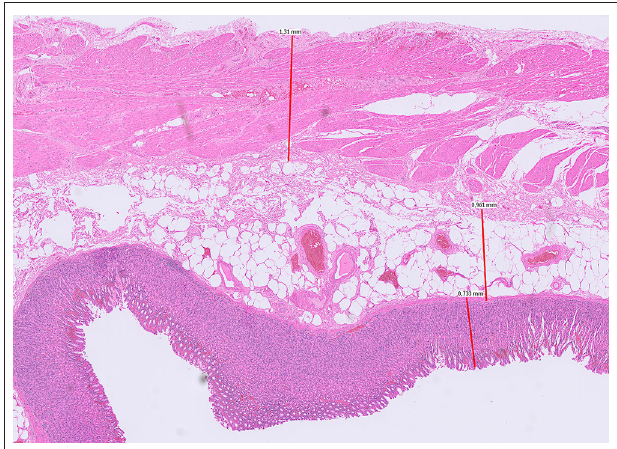
FIGURE 1 | Measurement of fundus-wall thickness (mucosa, submucosa, muscularis propria). Light microscopy of fundus wall 1cm down the proximal end of the staple